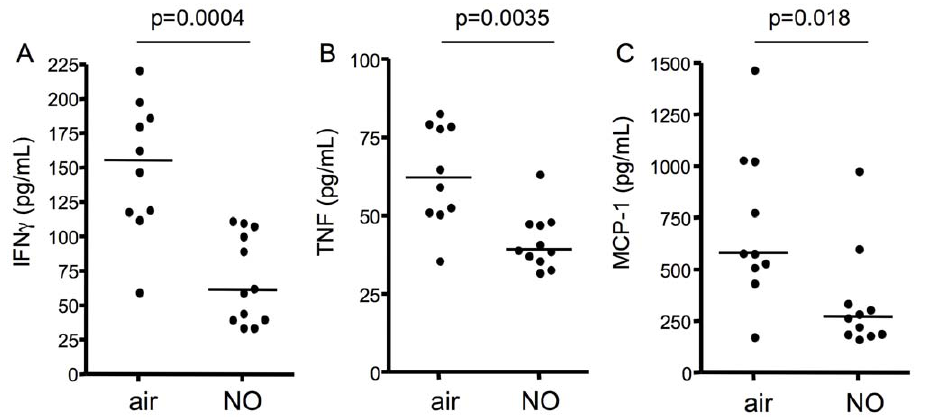
Figure 2. Inhaled NO reduces systemic inflammation in mice infected with P.berghei ANKA. Heparinized saphenous vein blood was collected on day 5 post-infection from mice that were prophylactically treated with either air or 80ppm NO. Plasma levels of (A) IFN c , (B) TNF, and (C) MCP-1 were determined using the mouse inflammation cytometric bead array. Statistical differences were assessed by Mann-Whitney test. For (A) p=0.0004, for (B) p=0.0035, for (C) p=0.018. Data are representative of 2 independent experiments. Plasma from uninfected mice was also tested as a control, and levels of all 3 cytokines were below the limit of detection.